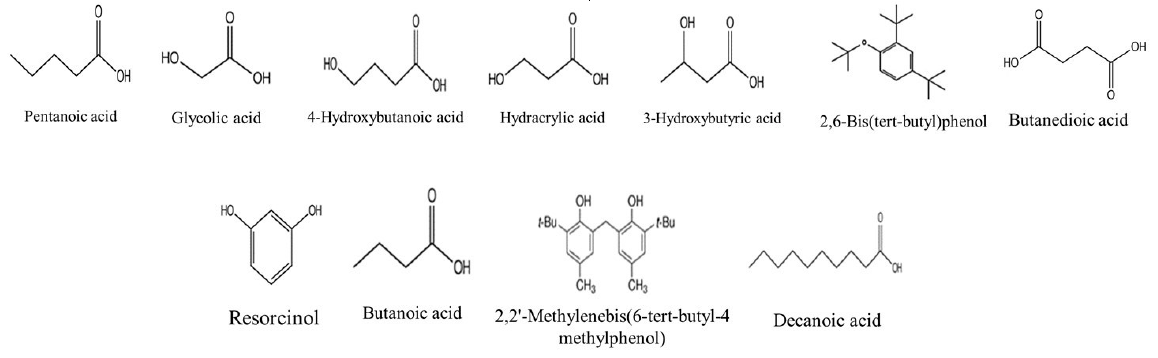
Figure 5. Compounds firstly identified in V. vinifera Stem part by GC-MS (after derivatization).